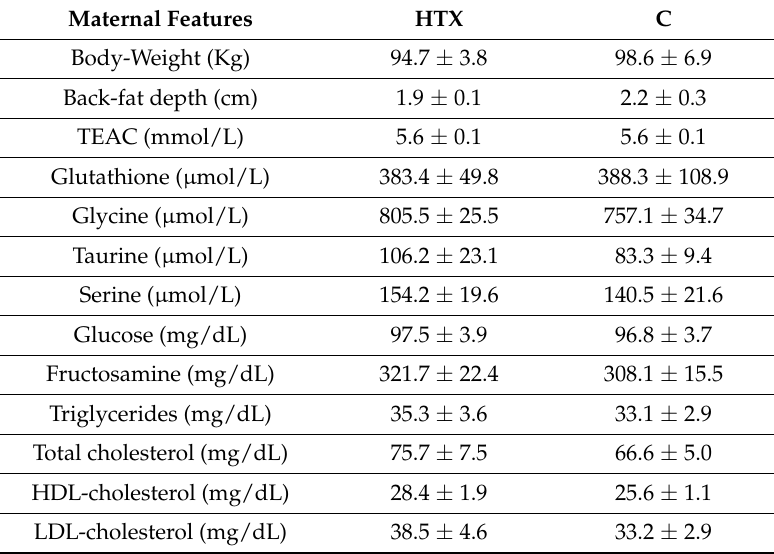
Table 1. Maternal features at day of sampling (Day 100 of pregnancy). Mean values ( ± SEM) in treated (Hydroxytyrosol; Group HTX) and control sows (Group C). TEAC accounts for Trolox Equivalent Antioxidant Capacity, HDL-c for high-density lipoproteins cholesterol and LDL-c for low-density lipoproteins